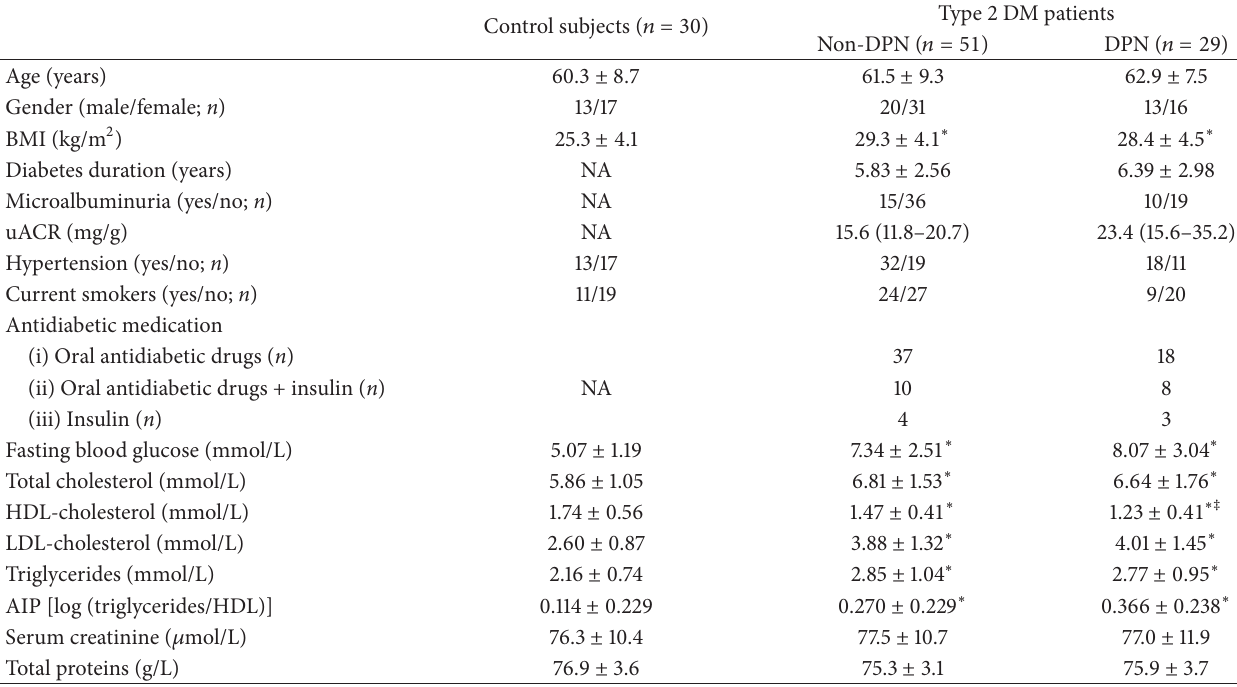
Table 1: Basic demographical and clinical parameters in control subjects and type 2 diabetes mellitus patients with and without diabetic peripheral